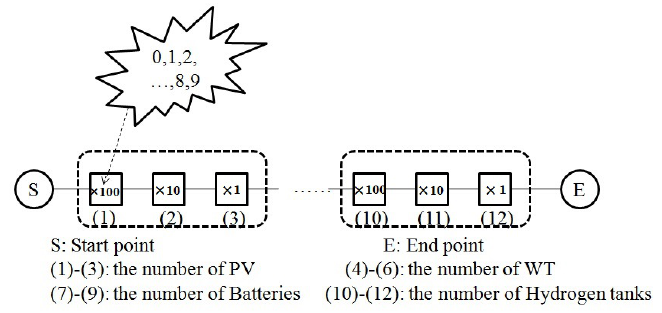
Figure 6. Encoding representation.